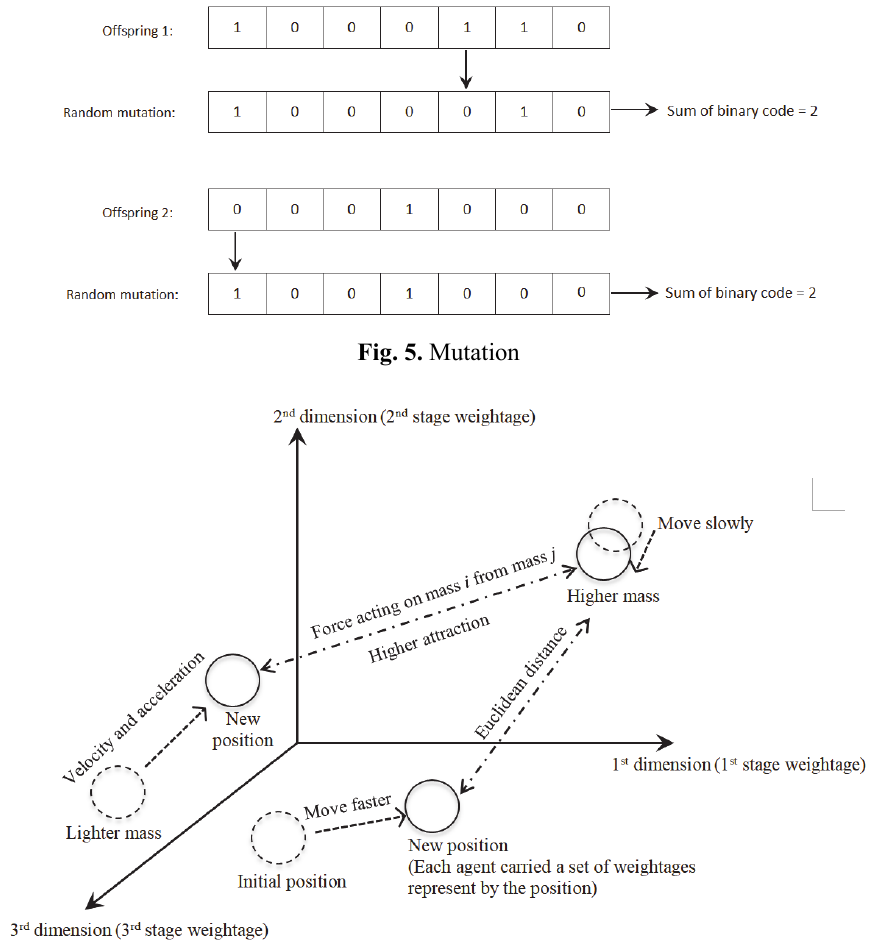
Fig. 6. Illustration of GSA search in 3 dimensional